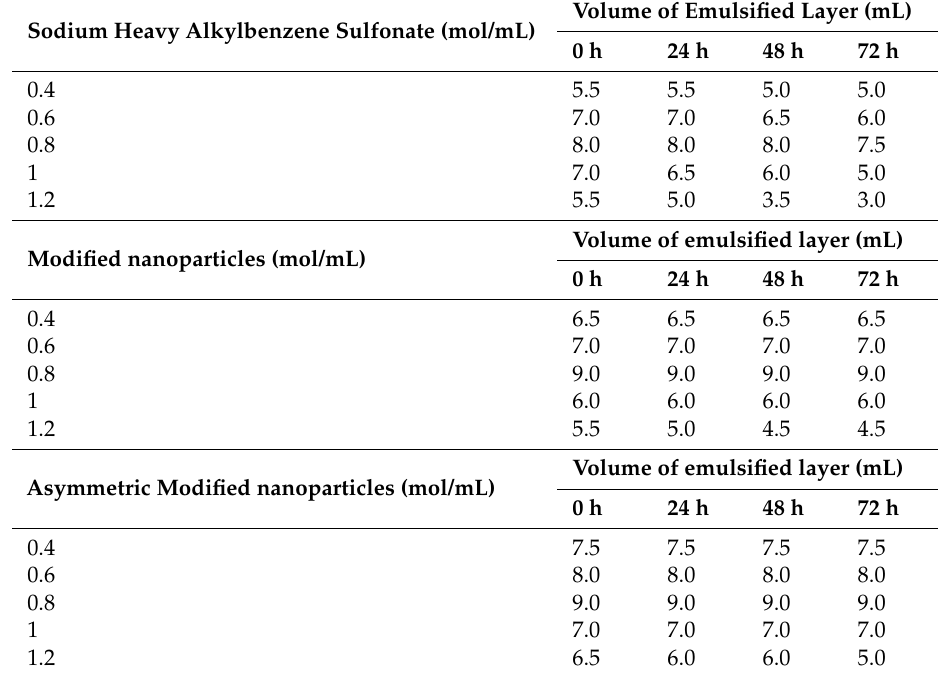
Table 5. Emulsifying performance